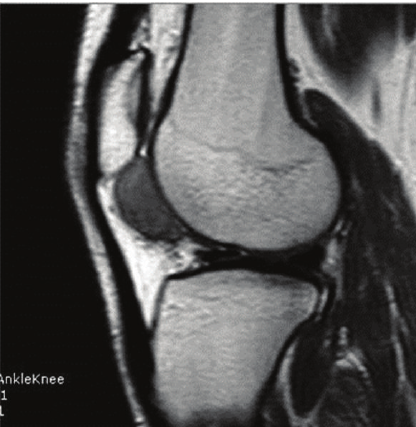
Figure 1: Hypointense lesion in infrapatellar region on T1-weighted MRI sequences.